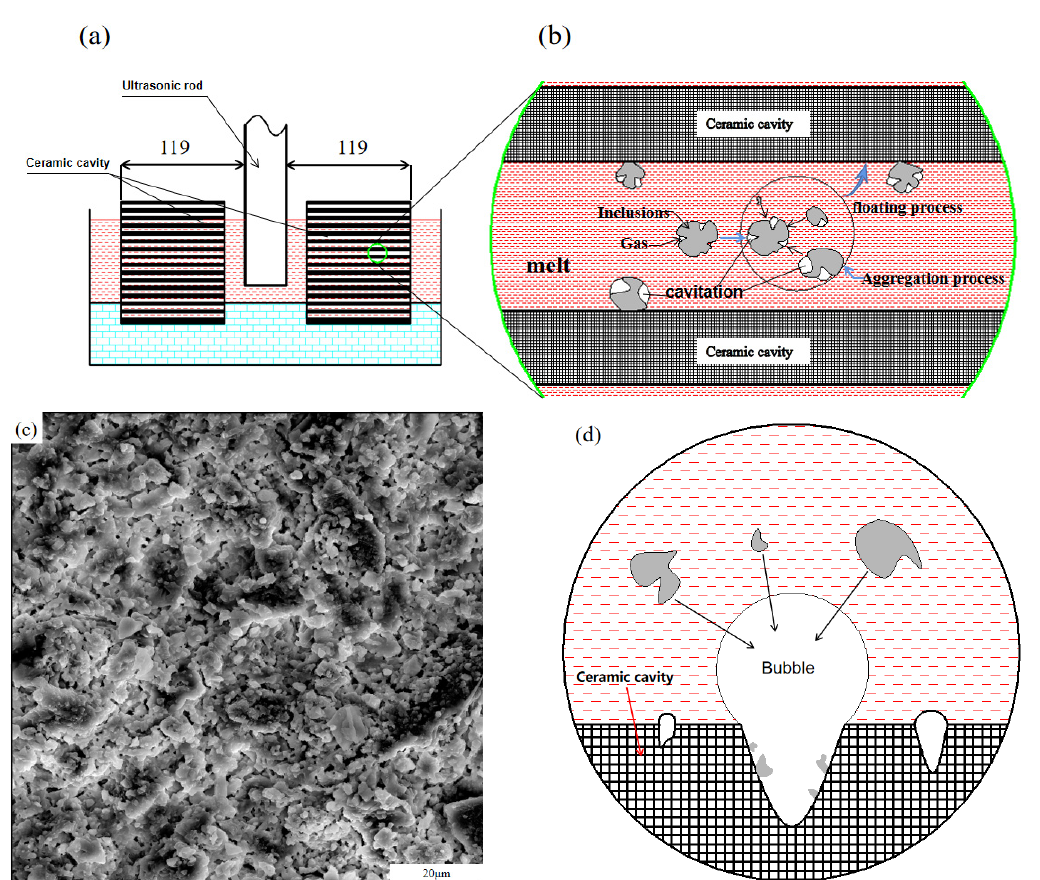
Figure 12. Ultrasonic purification process of inclusions: ( a , b ) cavitation purification principle, ( c ) microscopic morphology of the inner surface of the ceramic cavity, ( d ) principle diagram of adsorption of inclusions on the inner surface of the ceramic cavity.